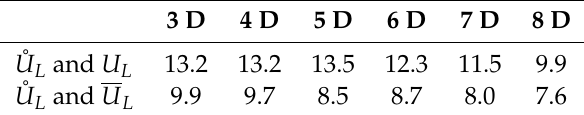
Table 1. Normalized rms differences ∆ rms (%) between synthetic scan wind speeds ˚ U L , the instantaneous values at the first second of the scan U L and the mean over the time it takes to complete the scan U L . Averages are over 80 3D scans, chosen to mimic the